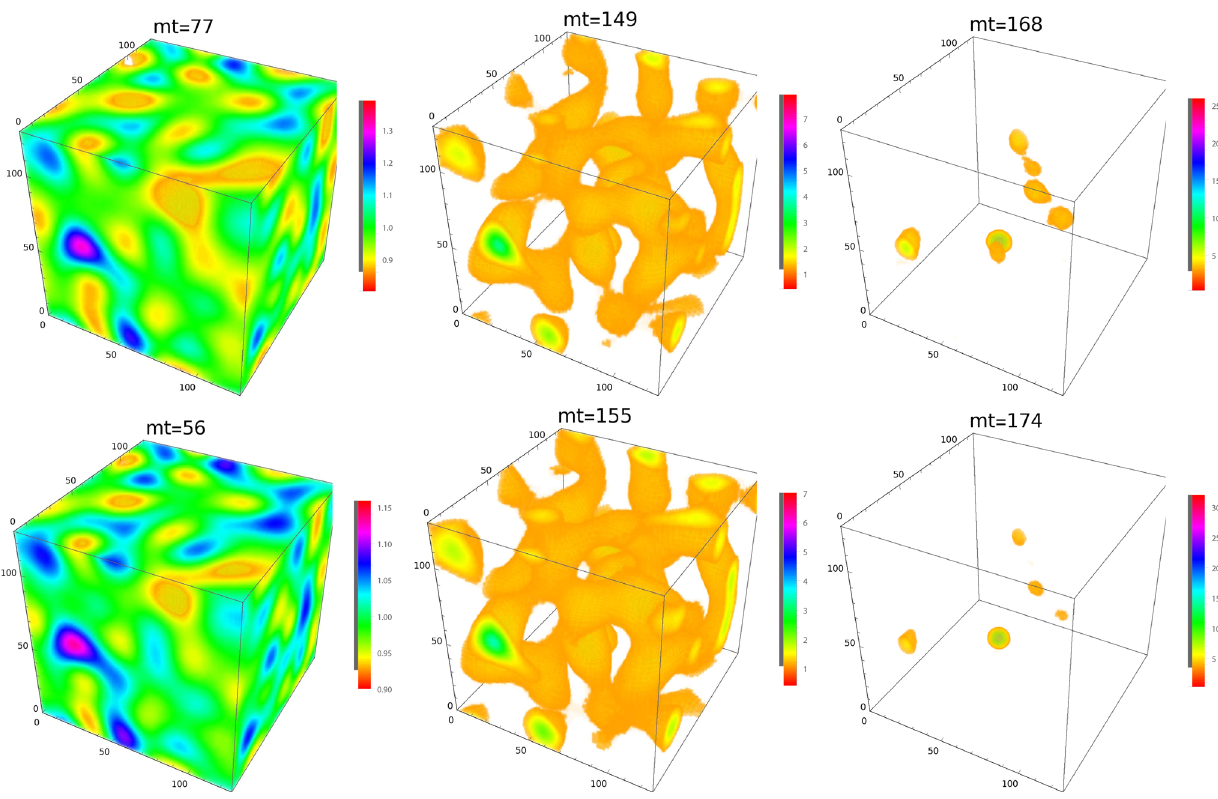
Fig. 1 The panels show the fragmentation of AD condensate and the formation of Q-balls in the case of K = 0 ,ξ = 10 (upper panles) and K = 0 . 001 ,ξ = 10 (lower panels), respectively. The corresponding